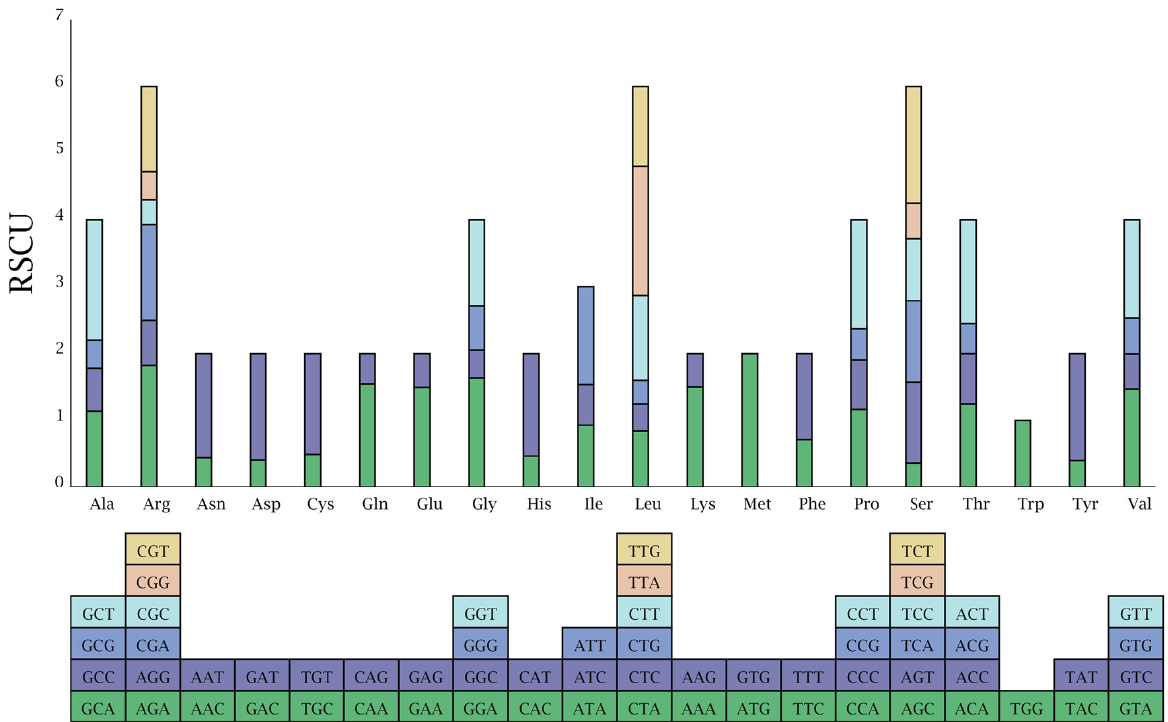
Figure 2. Relative synonymous codon usage (RSCU) bar chart of the wild chloroplast genome. Note: the box below represents all codons encoding each amino acid, and the height of the column above represents the sum of all codons RSCU values.